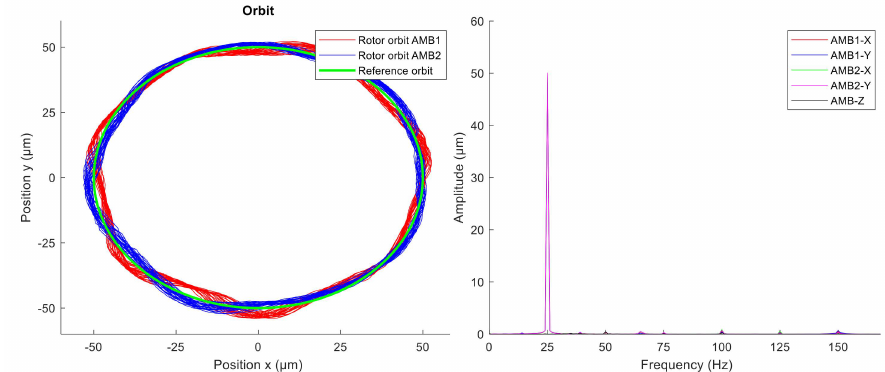
Figure 16. Measured rotor orbit ( left ) and signal amplitude spectra ( right ) with AVC. At first, the unbalance compensation was verified during the run-up test from 0 to 3000 rpm. When the spin speed was 3000 rpm, the orbit generation was started. Desired circular orbit was generated and maintained by the novel modified GNF algorithm. The levitation of the spinning rotor which was whirling in circular orbit was stable. Comparing the amplitude spectra (Figures 15 and 16), the vibration compensation by GNF eliminates the first and the third multiples (1X, 3X) of the rotor spin speed, which results in a more precise circular orbit shape. The measured position time signals in axes x and y were averaged to obtain a representative orbit shape, which was compared with a reference circle, as shown in Figure 17. The average error between the measured averaged orbit and the reference is listed in Table 3. The active vibration compensation improves the orbit shape by 81 and 85 percent in AMB1 and AMB2 respectively.